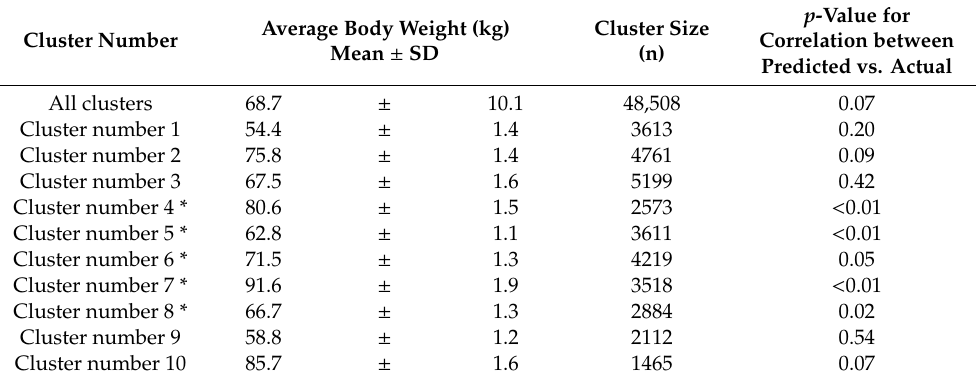
Figure 4. ( A ) Plotting the MAE (left y-axis, red line) and Calinski-Harabasz score (right y-axis, blue line) against number of clusters (x-axis). After 10 clusters, the reduction in MAE and the score tapers off, suggesting that could be a good number of clusters for further evaluation. The difference in MAE and Calinski-Harabasz score between 10 clusters and 40 clusters is <0.5 kg and ~10,000 points, which is much less compared to 2–10 clusters (from 4.3 kg and 50,000 points). ( B ) Plotting the change in MAE (y axis) and the percentage of predicted test subjects (x-axis). The red line represents the MAE for the combined global and local models and the blue line represents the MAE of only the local model. The different percentages cases that were predicted were obtained for different conditions (local and local and global together) by changing the criteria for the training set of the classifier that predicts the cluster of each case. Table 4. Clusters and their performance, relative to the fit of the complete data model and classifier